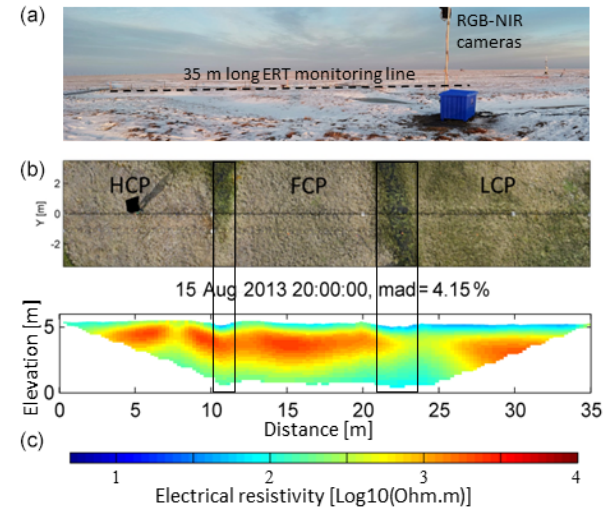
Figure 4. (a) Image of the intensive ERT transect (dash line) and pole-mounted cameras, which monitor the land surface variabil- ity of the whole transect. (b) Aerial view of the ERT transect (dashed line), which covers different types of polygons, namely, high-centered polygon (HCP), flat-centered polygon (FCP) and low-centered polygon (LCP). (c) An example of inversion of ERT data measured in August 2013. The top layer with low resistivity represents the active layer. The middle layer with high resistivity and the underlying less resistive layer correspond to permafrost and saline permafrost, respectively (see Dafflon et al., 2017, for more